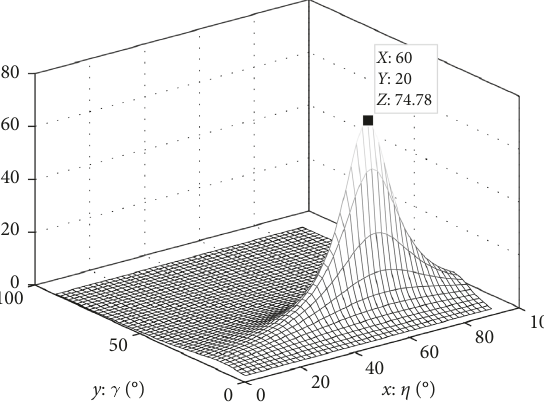
Figure 4: Polarization estimation result with ( θ , ϕ ) � ( 90 ° , − 40 ° ) .